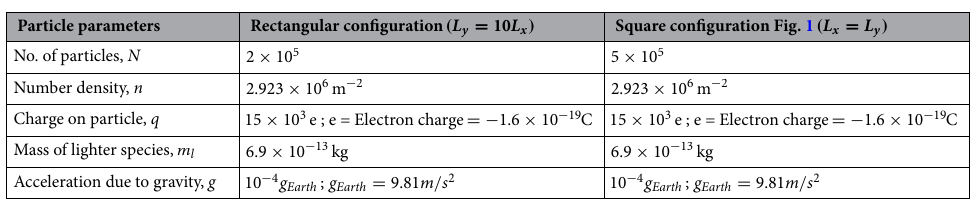
Table 2. Simulation parameters for RTI.